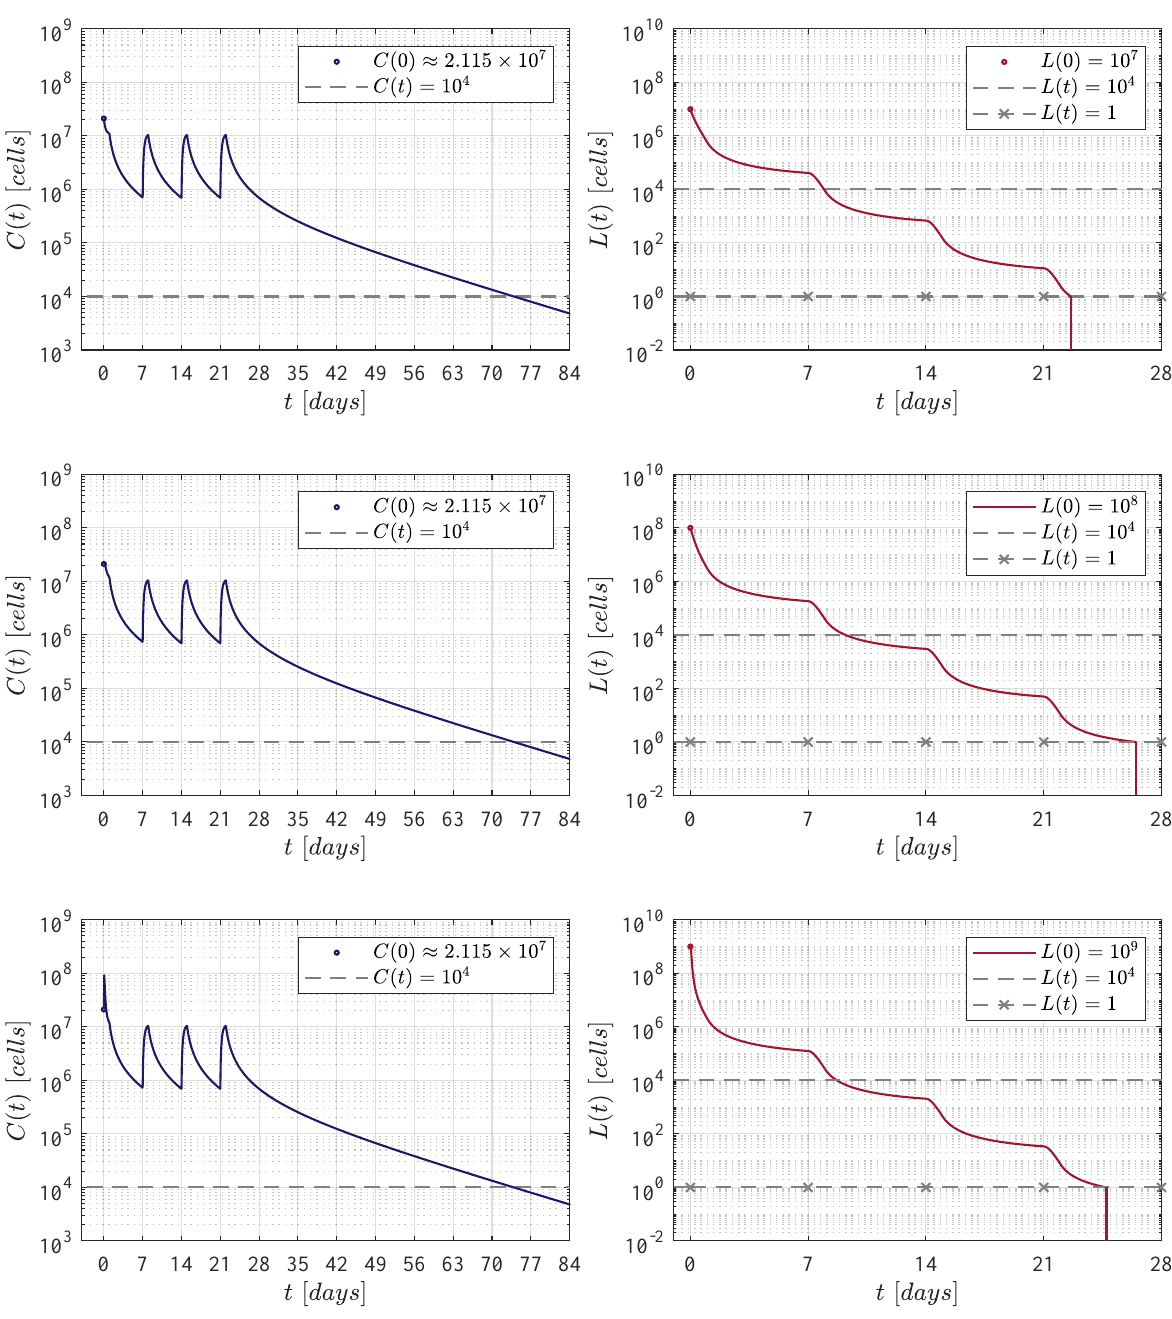
Figure 4. The weekly administration protocol. A total of four applications were applied at days 0, 7, 14 and 21. In silico experimentations allow us to determine that a dose of 21, 140, 072 CAR-T cells was necessary to achieve CR by day